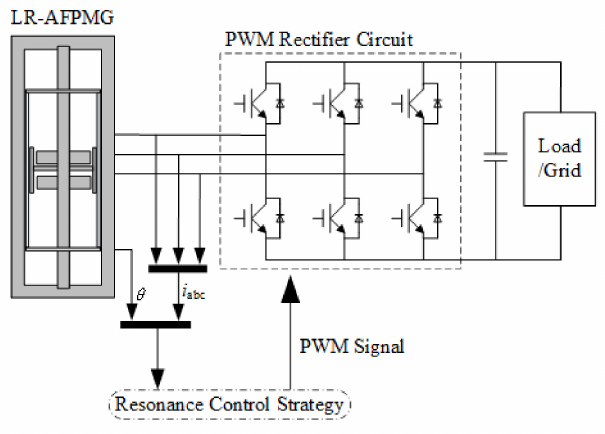
Figure 2. Generator side control block